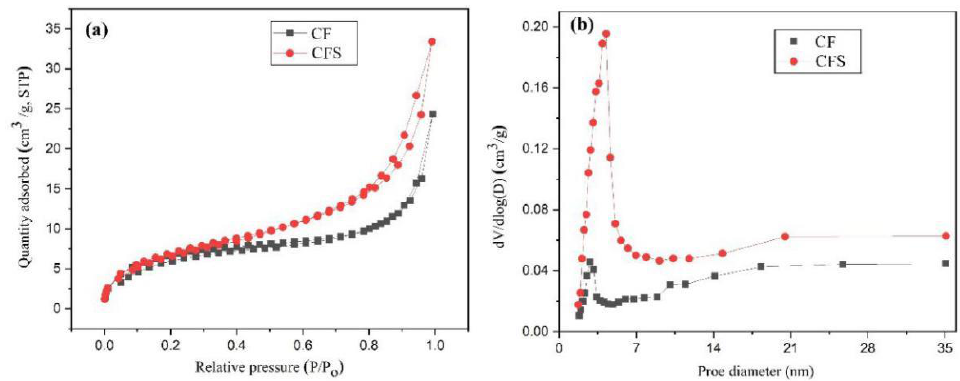
Figure 4. The N 2 adsorption-desorption isotherms ( a ) and pore diameter distribution ( b ) of CF and CFS materials.